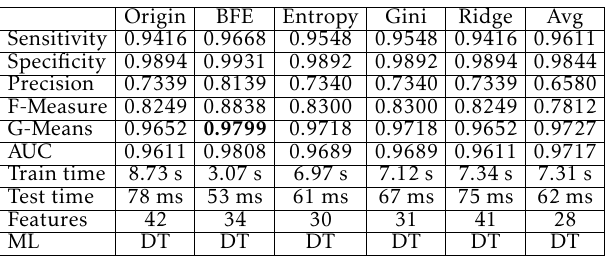
Table 14. Compare CA-BFE with other algorithms on